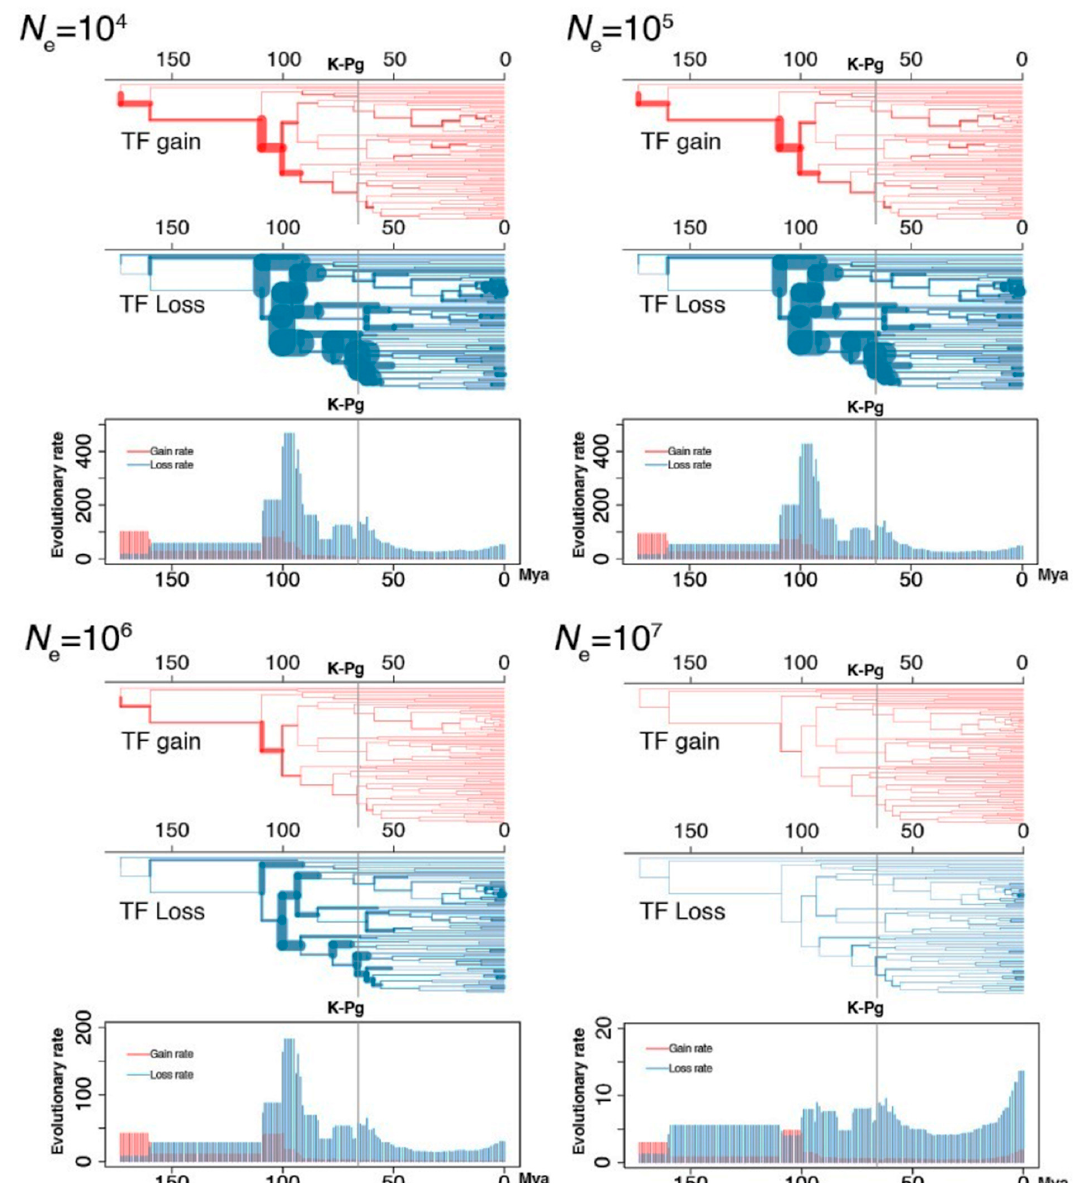
Figure 2. Transcription factor (TF) events inferred using four different effective population sizes ( N e )—10 4 , 10 5 , 10 6 and 10 7 —as a threshold when considering incomplete lineage sorting and short branches. TF losses and gains are represented by blue and red bars, respectively. The width of each branch is proportional to the rate of TF gain (or loss). The bar plots are mean evolutionary rate (mean TF gain or loss events of each million years).